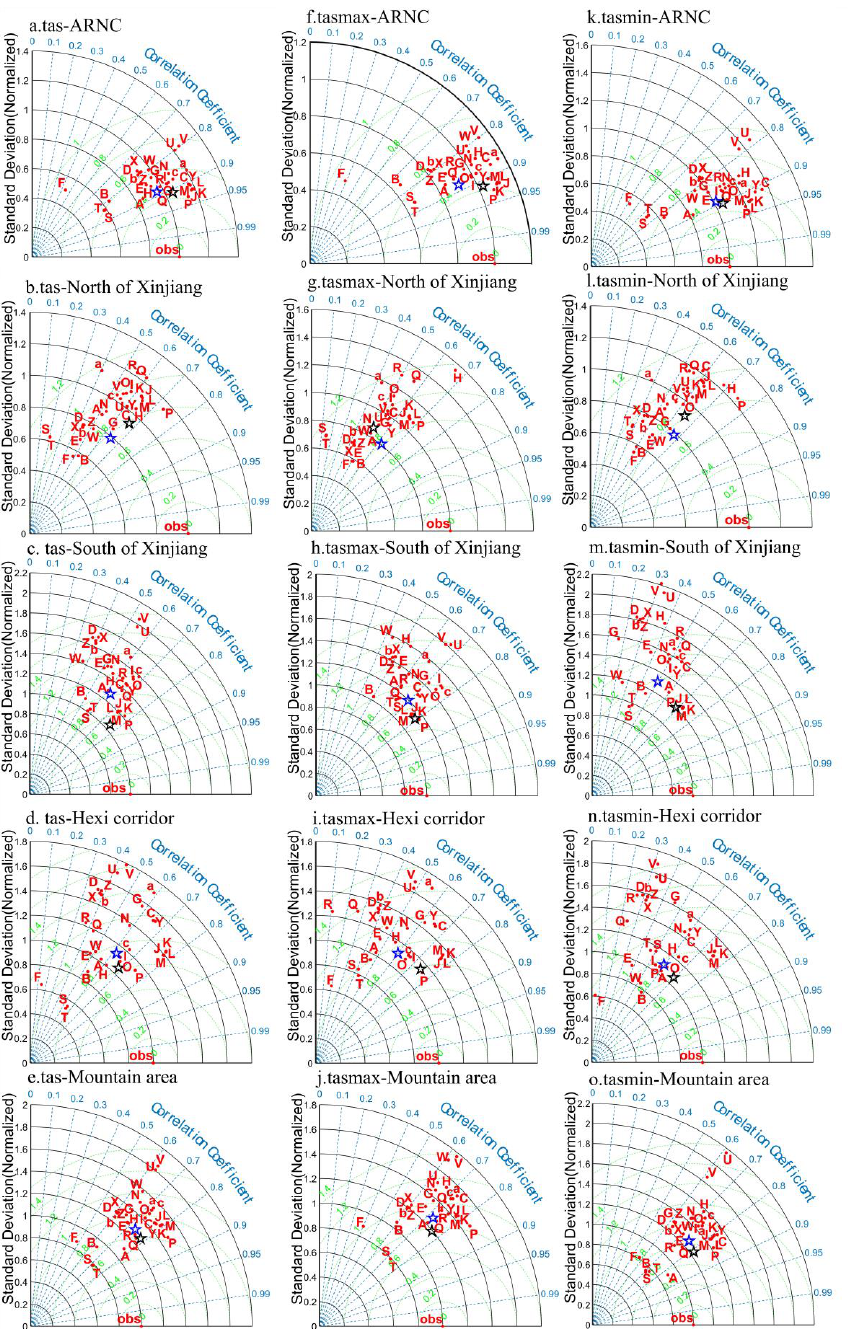
Figure 4. Taylor diagram of simulated climate mean field relative to observation field in the ARNC during 1961–2014. Letters represent model ID listed in Table 2; the blue pentagram represents MME, and the black pentagram represents PME. The left column, tas ( a – e ); the middle column, tasmax ( f – j ); the right column, tasmin ( k – o